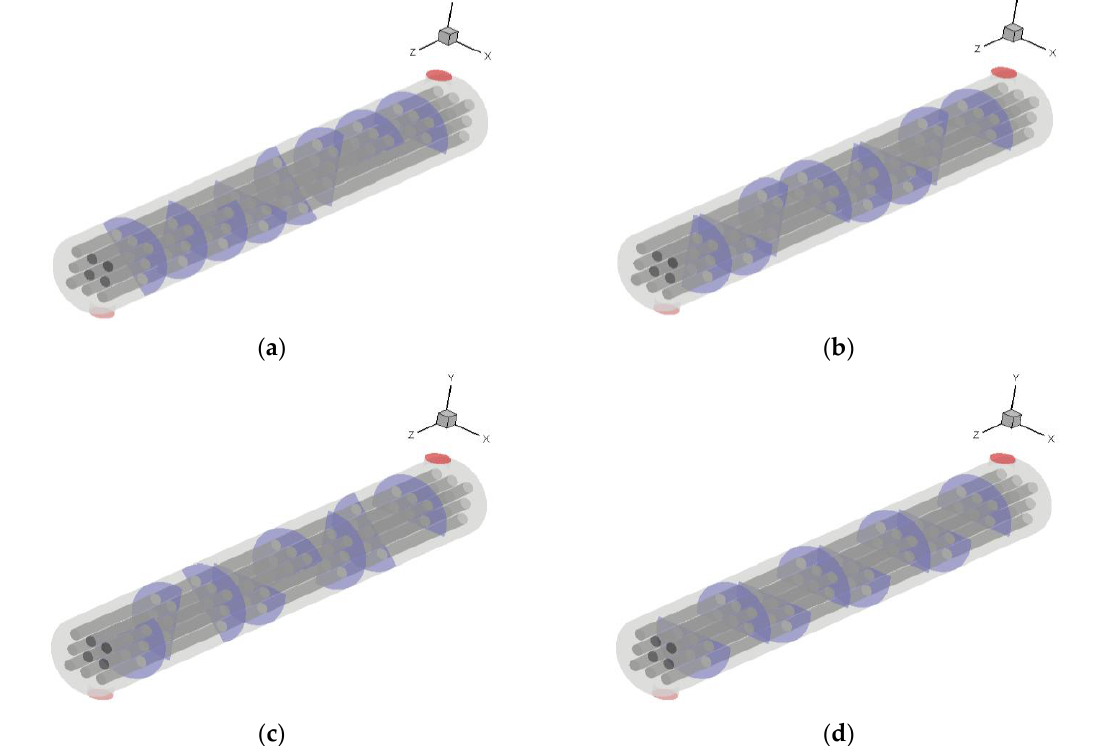
Figure 2. Schematic of the computational domain of shell and tube heat exchanger with baffle rotation angles of ( a ) 45°, ( b ) 90°, ( c ) 135°, and ( d ) 180°.